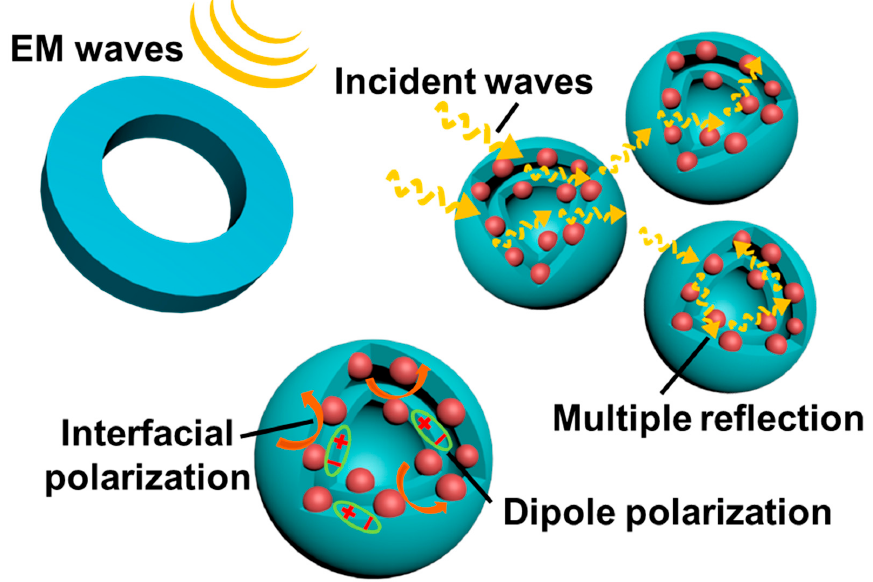
Figure 8. The schematic illustration of the physical model for microwave absorption mechanisms in DS − Mo 2 C/C